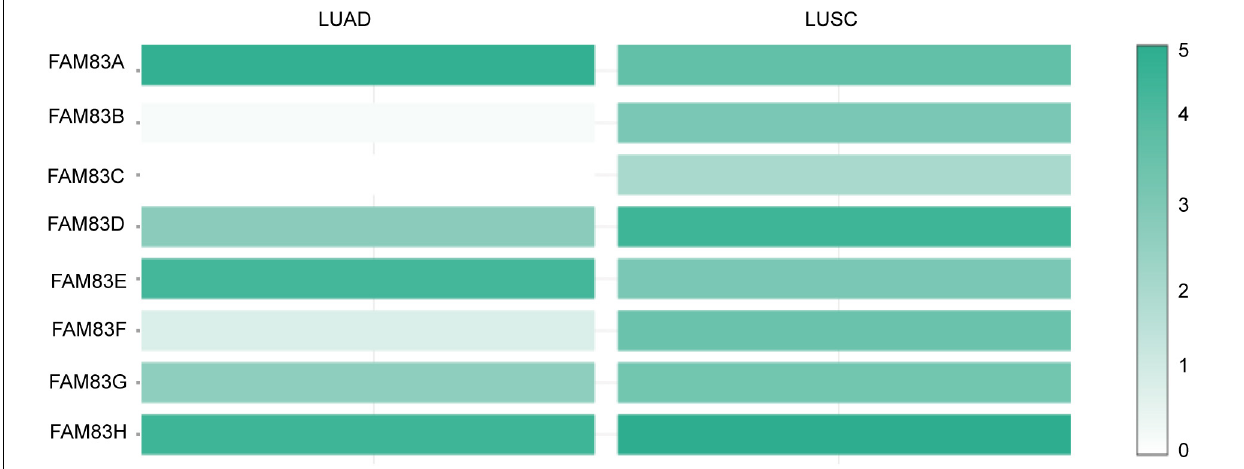
FIGURE 3 | The relative level of FAM83 family in NSCLC. FAM83A was the highest expression in LUAD and FAM83H was the highest in